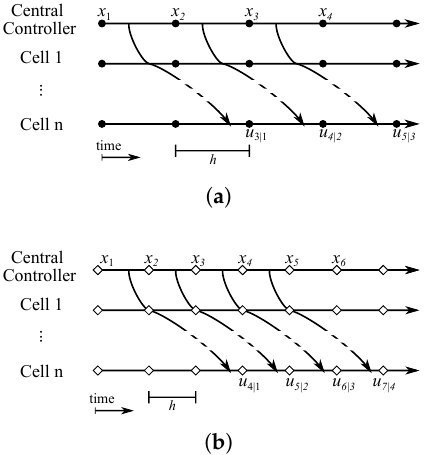
Figure 3. The network introduces additional delay to the actuation. As the sampling period reduces from ( a ) to ( b ), the delay is higher in terms of samples. x k is the state vector in instant k, and u k | k − n is the plant input vector in instant k calculated in k −